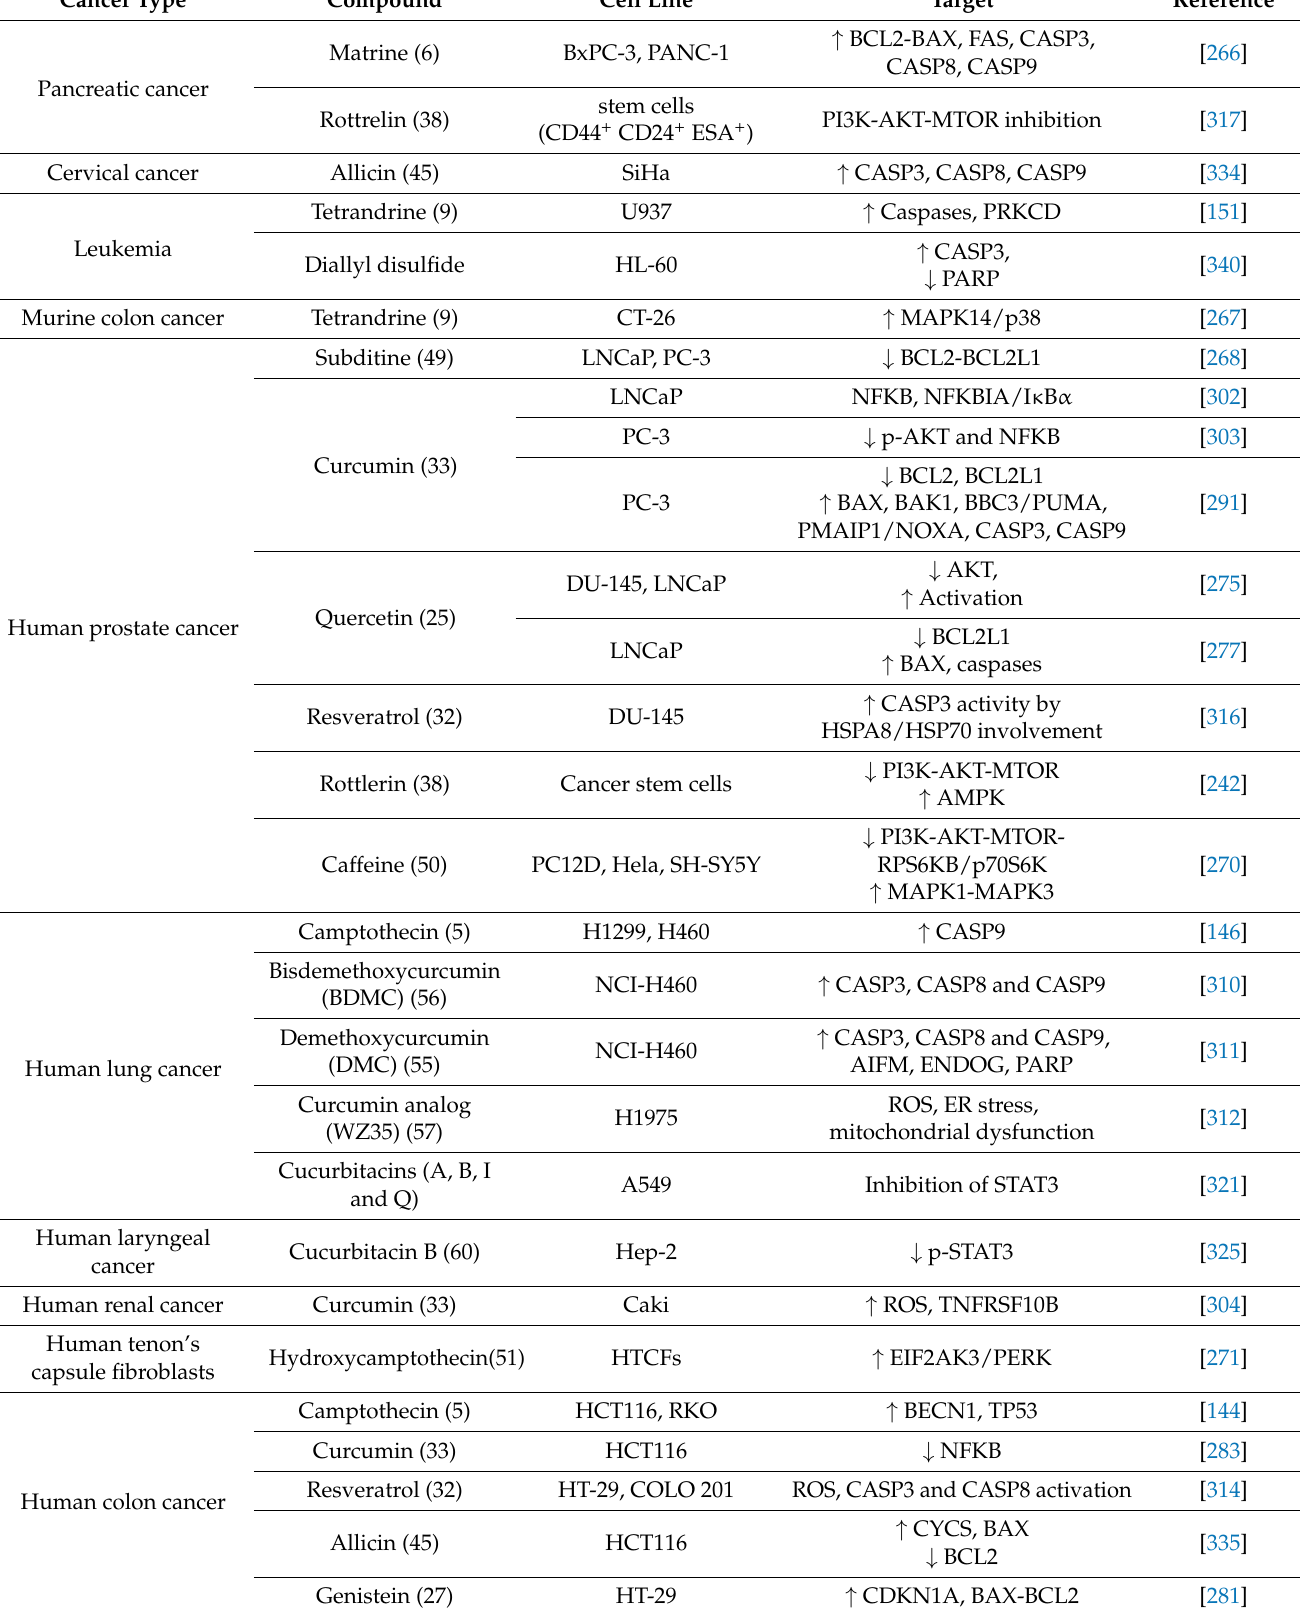
Table 2. Natural apoptosis modulators and their effect on signal transduction